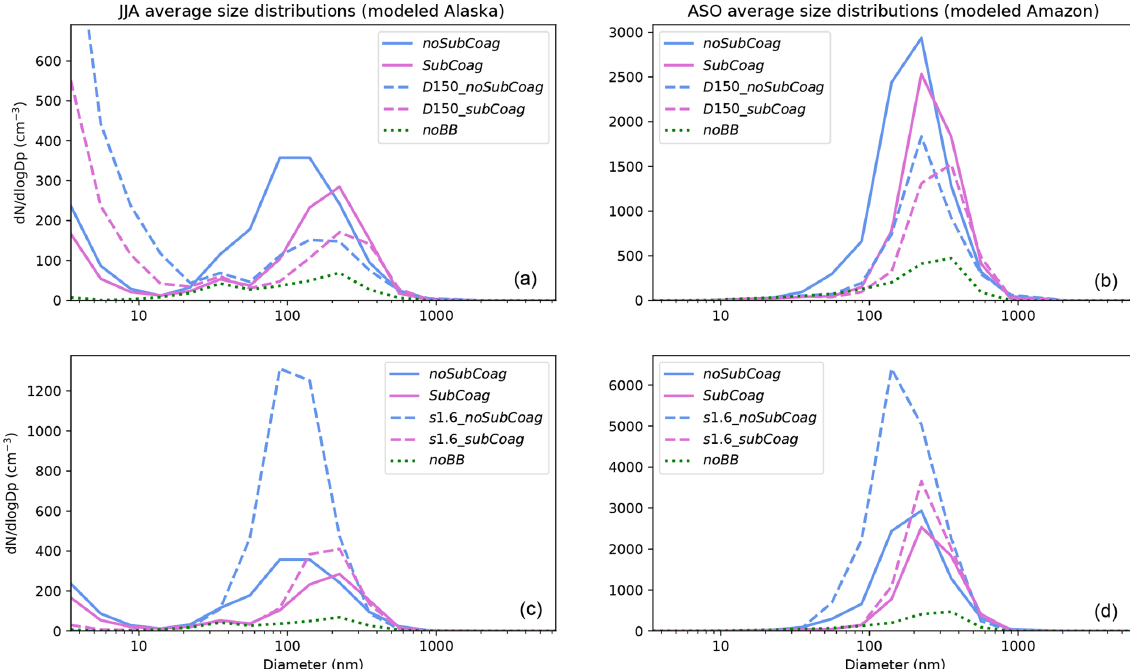
Figure 5. Predicted, grid-resolved surface-level aerosol size distributions with GFED biomass burning emissions over Alaska at 62 ◦ N, 140 ◦ W, averaged over the June, July, and August fire season (a, c) and the Amazon at 6 ◦ S, 60 ◦ W, averaged over the August, September, and October fire season (b, d) . All panels show the size distributions for the noBB , noSubCoag , and SubCoag simulations in the green, solid blue, and solid pink dashed lines, respectively. Panels (a) and (b) show the sensitivity to the emitted median diameter, and panels (c) and (d) show the sensitivity to the emitted modal width. Note the different y axis